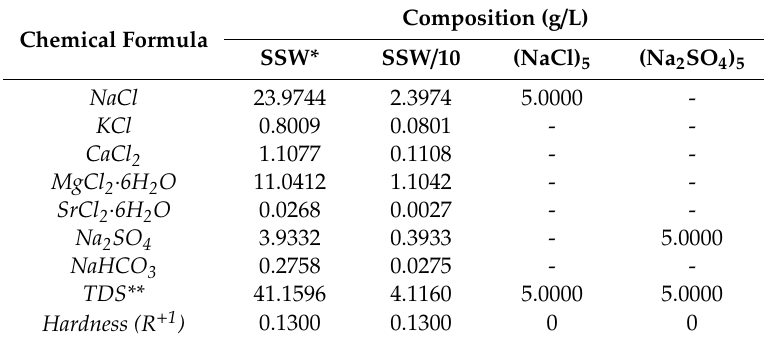
Table 1. Composition of the brines used in Brine Group A (BGA) to dissolve the polymer